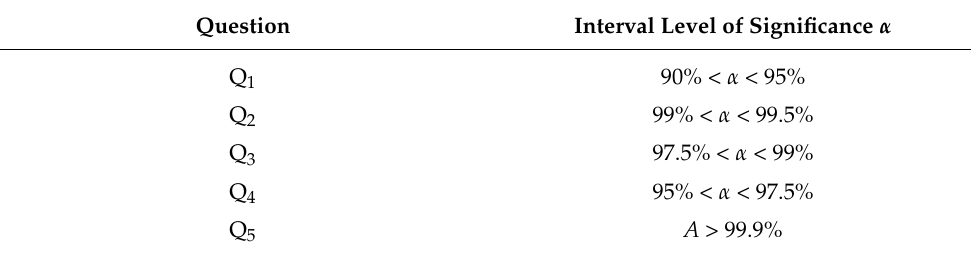
Table 3. Level of significance of the values of J u,v for each